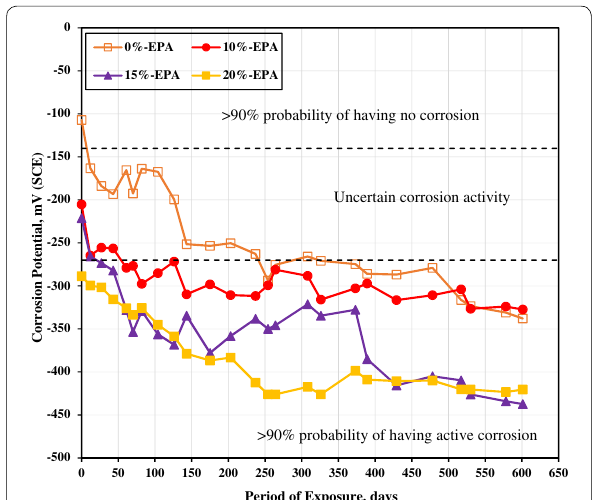
Fig. 13 Half-cell corrosion potentials on steel embedded in EPA-modified concrete.